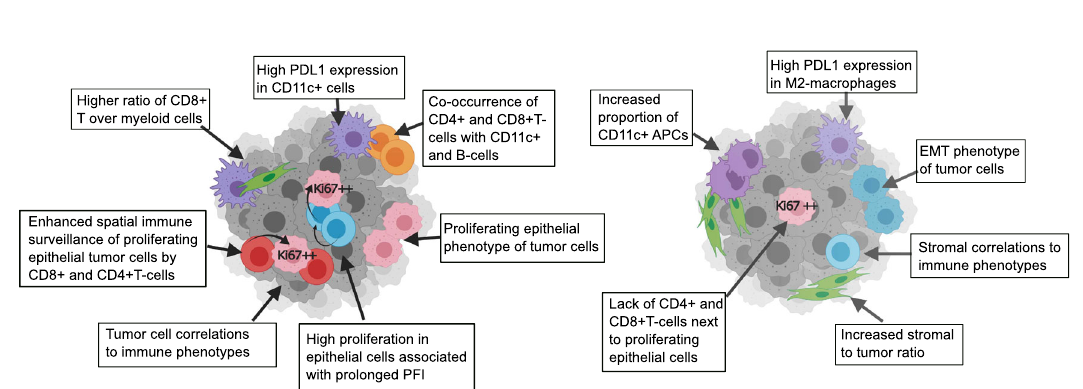
Fig. 5 Proliferative state delineates spatial cell-cell interactions of the tumor-immune microenvironment in BRCA1/2 mut and HRwt tumors. a A schematic representation of cell-cell spatial interactions signi fi cantly enriched (FDR < 0.1) in BRCA1/2 mut tumors ( n = 31, blue arrows) and in HRwt tumors ( n = 13, red arrows). The arrowheads point to the cell type surrounding the cell type denoted by the arrow base. The size of the arrows indicate the FDR- corrected p-value. The dotplot in Fig. S5a denotes the corresponding fold change values. b Representative multiplex immuno fl uorescence images showing highly proliferating epithelial cells co-localizing with CD8 + T-cells in BRCA1/2 mut tumors, and highly proliferating epithelial cells residing further away from CD8 + T-cells in HRwt tumors as shown in a . Experiment was repeated for n = 31 BRCA1/2 mut tumors and n = 13 HRwt tumors. c Kaplan-Meier graphs showing high fraction of CD4 + T-cells and d high fraction of CD8 + T-cells neighboring proliferating epithelial cells associate with an improved PFI in patients with BRCA1/2 mut tumors. Median was used as a cut-off for high and low fractions. Number of patients at risk is shown at the bottom of each Kaplan-Meier graph. The comparisons between the groups were performed using the log-rank test. e A schematic illustration of functional state and spatial cell-cell interaction analysis. Proliferating epithelial cells were each characterized by their CD4 + T-cell and CD8 + T-cell spatial neighborhood status. Next, Ki67 marker expression was compared in proliferating epithelial cells with different cell-cell spatial neighborhoods in BRCA1/2 mut and HRwt tumors separately. f Violin plots showing the probability densities of Ki67 expression in proliferating epithelial cells in the different CD8 + T-cell neighborhood and HR-groups. g Violin plots showing the probability densities of Ki67 expression in proliferating epithelial cells in the different CD4 + T-cell neighborhood and HR-groups. In the box plots inside violin plots the black horizontal lines represent the sample medians, the boxes extend from fi rst to third quartile and whiskers indicate values at 1.5 times the interquartile range. Two-sided wilcoxon rank-sum test was used for pairwise comparisons. Source data are provided with the paper.